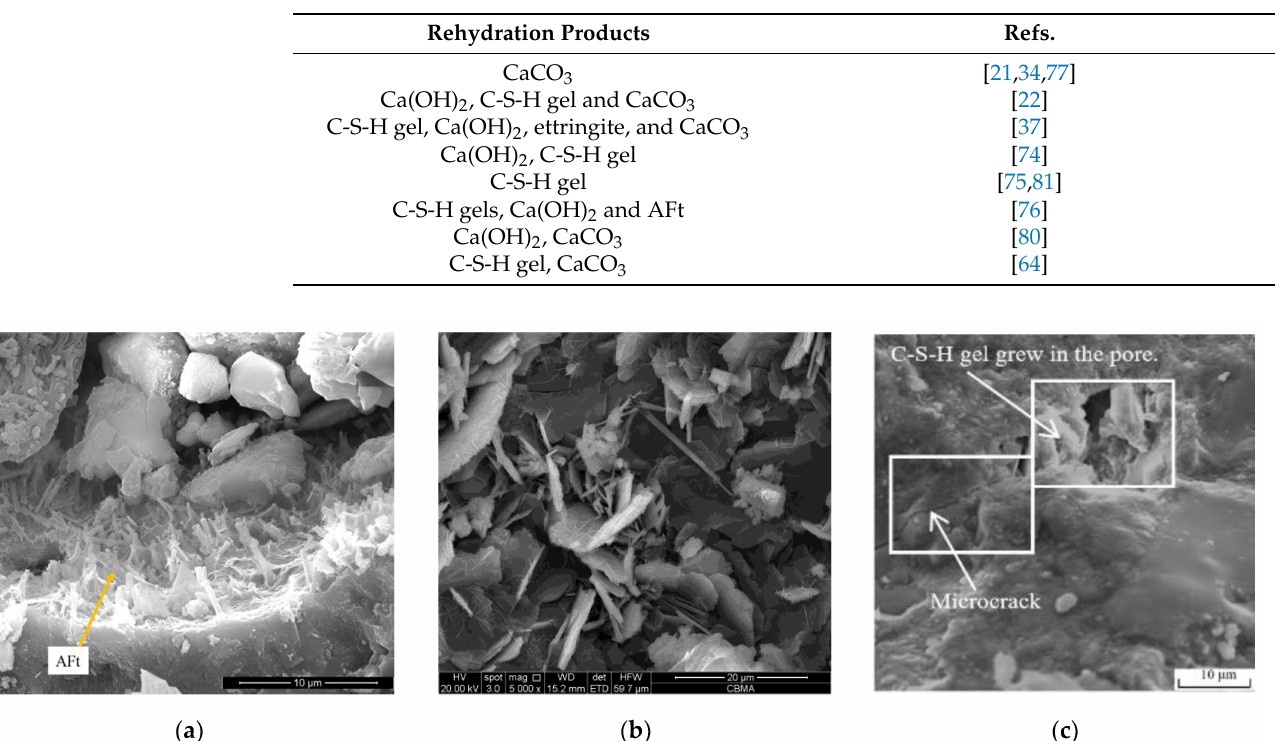
Table 3. Rehydration products.